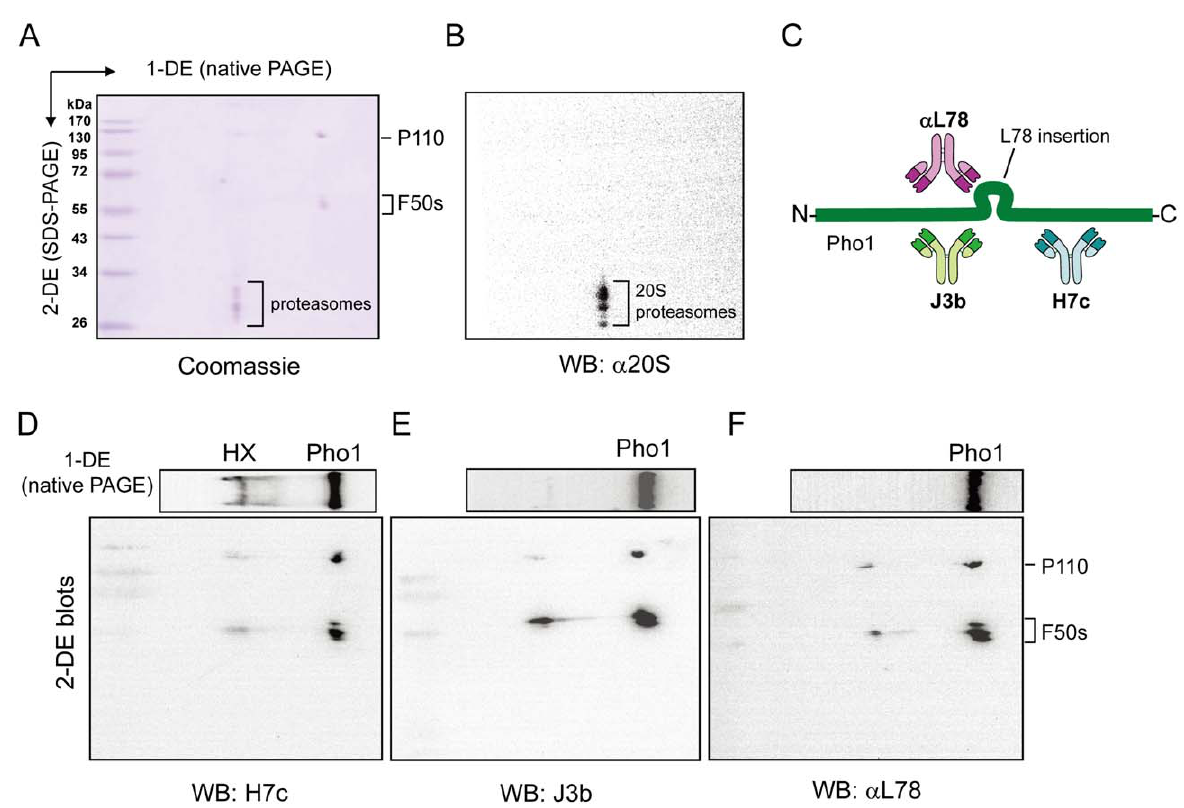
Figure 4. The 20S proteasome interacts with the N-terminal domain and L78 insertion of Pho1. To obtain a better electrophoresis resolution, HX was separated by native PAGE for the first dimension (1-DE) and then subsequently applied to the second-dimension SDS-PAGE (2-DE). ( A ) The 2-DE gel was stained with Coomassie to detect P110, F50s and multiple 20S proteasome subunits. ( B ) The 2-DE gel was transferred to a PVDF membrane and analyzed by western blotting using the rabbit anti-sweet potato root 20S proteasome antiserum. ( C ) The simple diagram showed the corresponding recognition site of J3b, H7c or a L78 antibody on Pho1. The letters ‘‘N’’ and ‘‘C’’ indicate the N terminus and the C terminus of Pho1, respectively. To investigate the interaction regions between Pho1 and the 20S proteasome, the 1-DE gels and the 2-DE gels were transferred to PVDF membranes and analyzed by western blotting using H7c ( D ), J3b ( E ) and a L78 ( F ) primary antibodies. J3b and a L78 did not bind to the native form of HX.